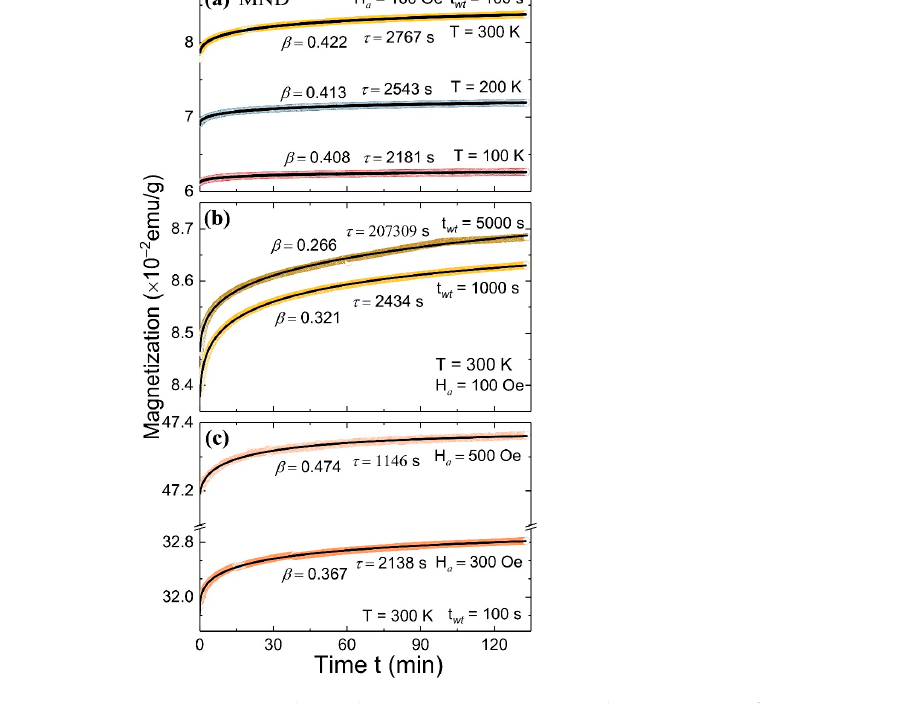
Figure 4. Time dependent magnetic moment relaxation curve from MND measured at ( a ) different temperatures (H a = 100 Oe, t wt = 100 s), ( b ) with different waiting time (H a = 100 Oe, T = 300 K) and ( c ) at different magnetic field (T = 300 K, t wt = 100 s).